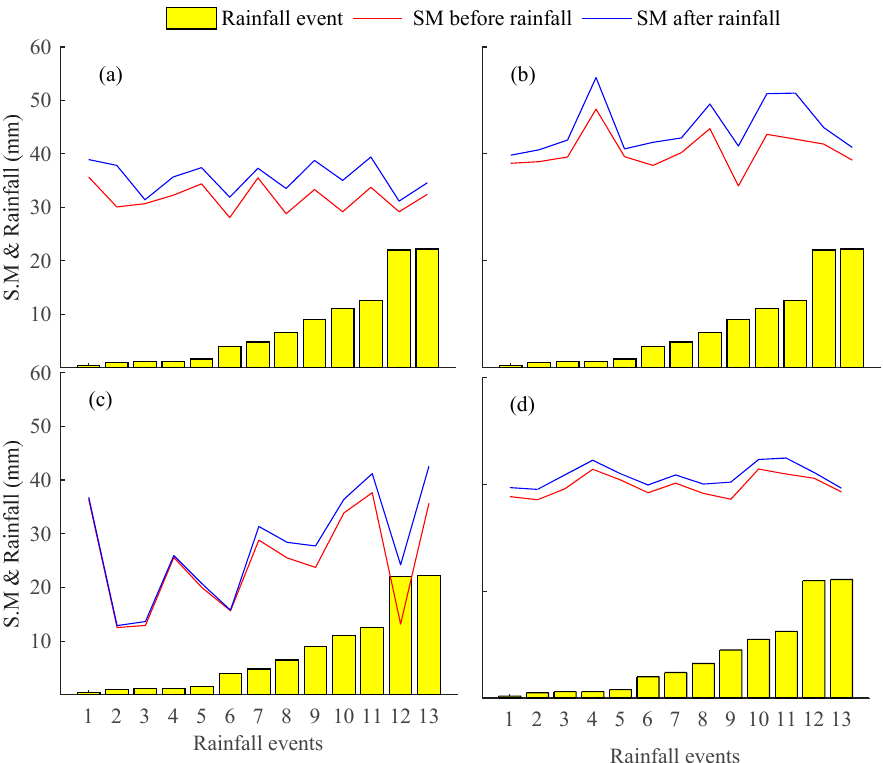
Figure 8. Effect of rainfall events on soil moisture (SM) content in ( a–d ) treatments